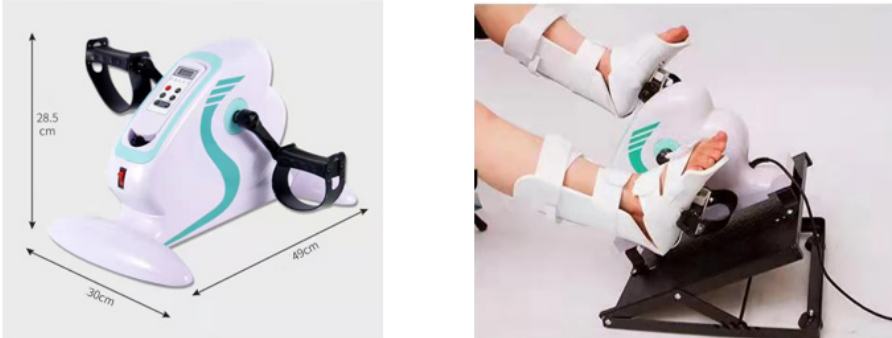
Figure 3. Static pedal for intradialytic exercise in the control group (obtained from Healthy Care Monitor Store).